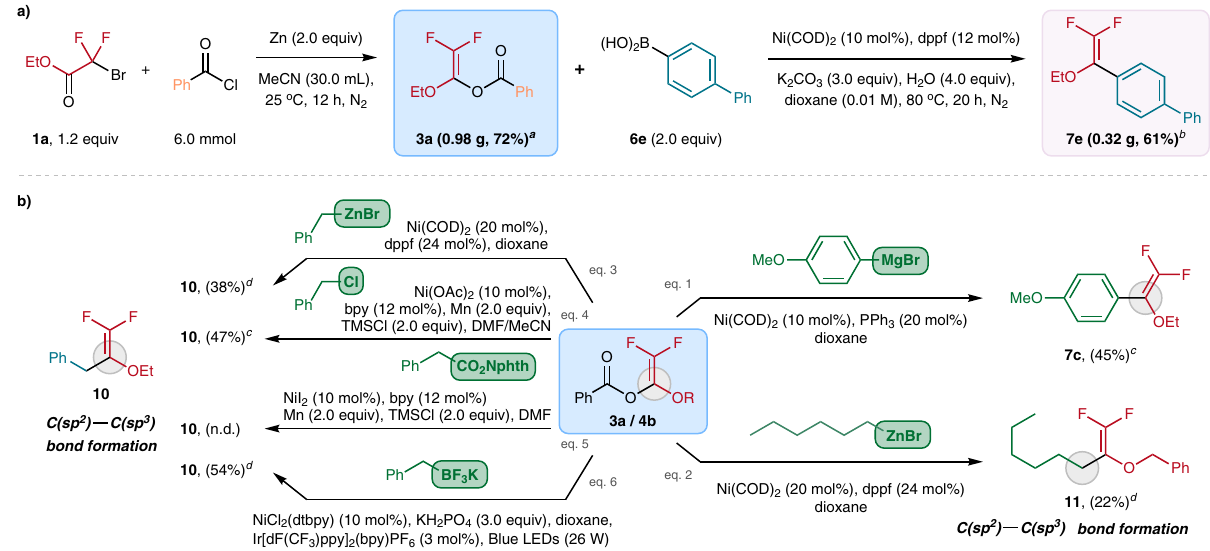
Fig. 4 Synthetic applications. a Gram-scale operation of the BzO-DFs synthesis and the subsequent Ni-catalyzed arylation. b Exploration of the coupling partners with the BzO-DF building blocks: catalytic protocols based on the uses of organometallic nucleophiles such as organomagnesium/-zinc and organotri fl uoroborates as well as electrophiles such as benzyl chlorides have been developed. a 1a (1.46 g) was used at starting material. b 3a (0.46 g) was used for the Ni-catalyzed coupling reaction. c NMR yield determined by 19 F NMR with tri fl uorotoluene as internal standard. d Isolated Mn (2.0 equiv) (Fig. 4b, eq. 4). Redox-active ester failed to